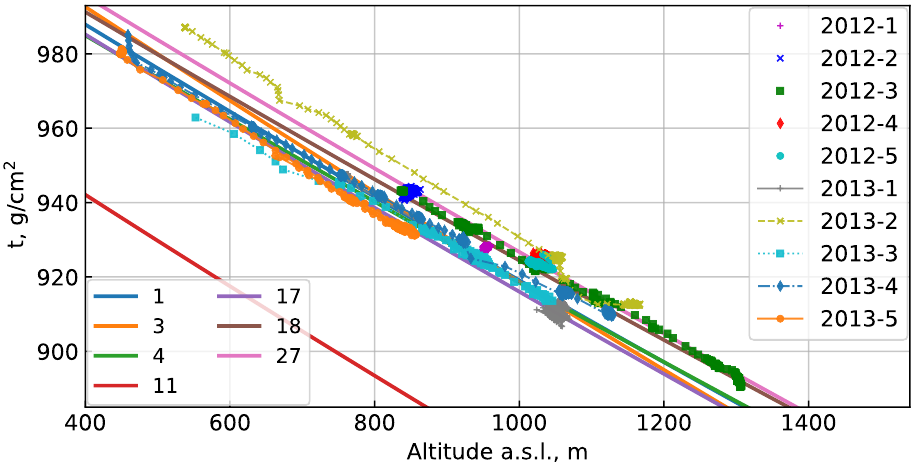
Figure 17. Mass overburden versus altitude experimental data (points) in each flight and CORSIKA profiles (solid lines with corresponding model numbers). For preliminary SPHERE-2 modeling and analysis, the N0 11 atmosphere was used.